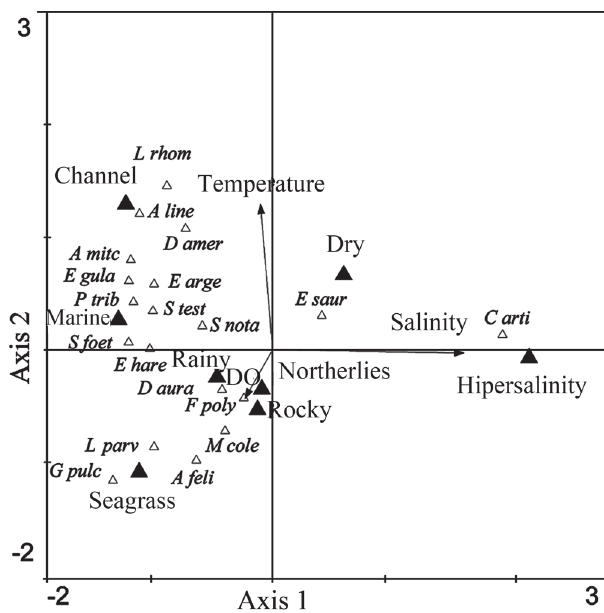
Fig. 4. Canonical Correspondence Analysis bi-plot. Length and direction of arrows indicate the relative importance and force of change in the environmental variables. CCA axis 1 and CCA axis 2 had eigen values of 0.629 and 0.214 respectively. The habitats and seasons are indicated. Only the species approximately 90% of IVI are shown. Species abbreviations are the first letter of the genus name and first four letters of the species name. DO: dissolved oxygen.